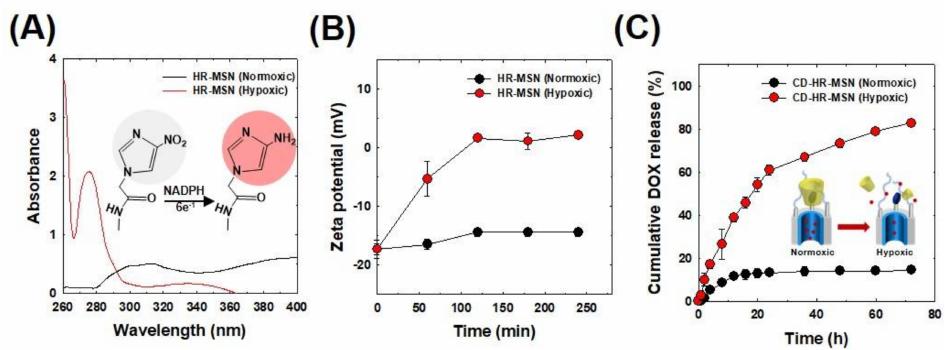
Figure 4. ( A ) UV/VIS spectrum of hypoxia-responsive mesoporous silica nanoparticles (HR-MSN) incubated under normoxic and hypoxic conditions for 3 h. Measurements were performed in PBS buffer containing 100 µ M NADPH as an electron donor. The illustration shows the reduction of nitro to amine under hypoxic conditions; ( B ) Time-dependent change in surface charge potentials of HR-MSN incubated under normoxic and hypoxic conditions; and, ( C ) In vitro DOX release profiles from